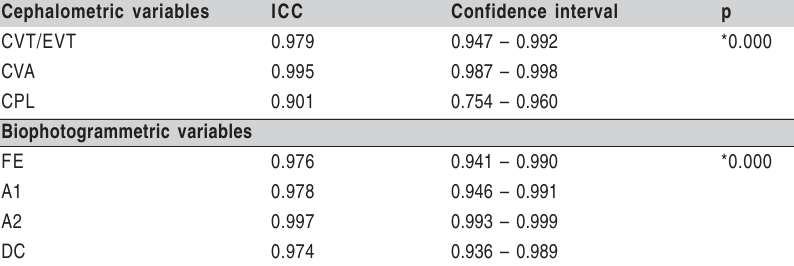
Table 1 – Intra-examiner reliability of cephalometric and biophotogrammetric variables